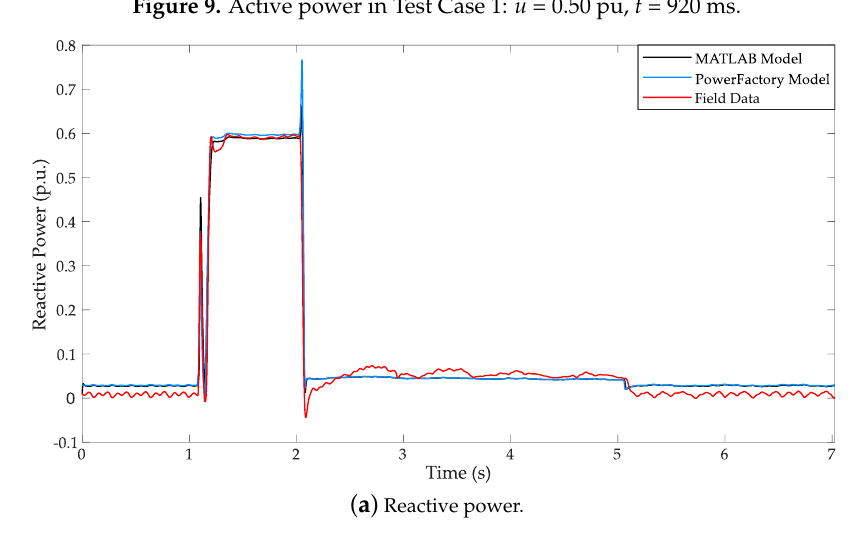
Figure 9. Active power in Test Case 1: u = 0.50 pu, t = 920 ms.